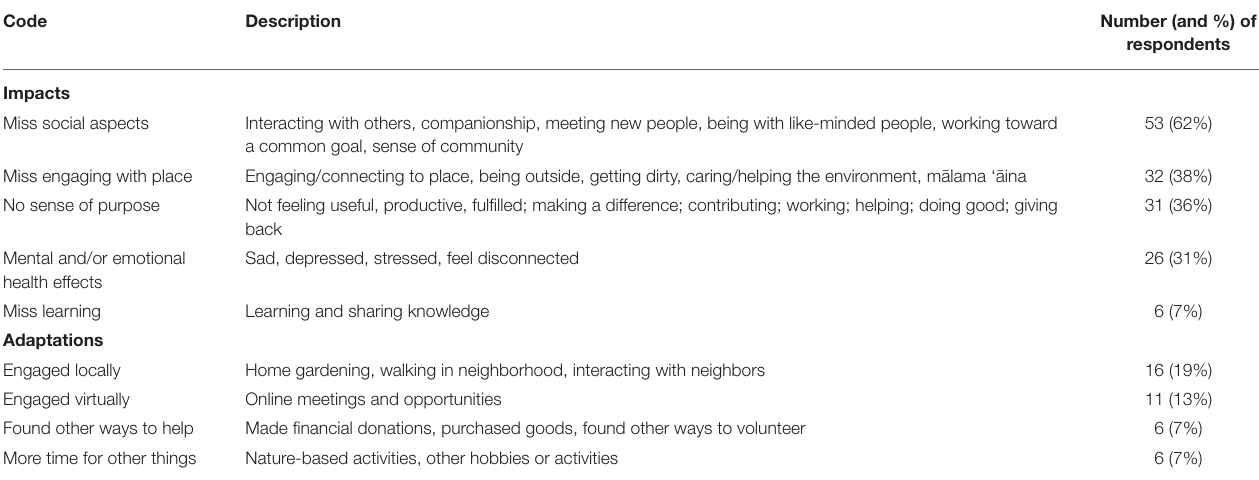
TABLE 3 | Coded impacts and adaptations of decreased engagement with environmental stewardship groups by